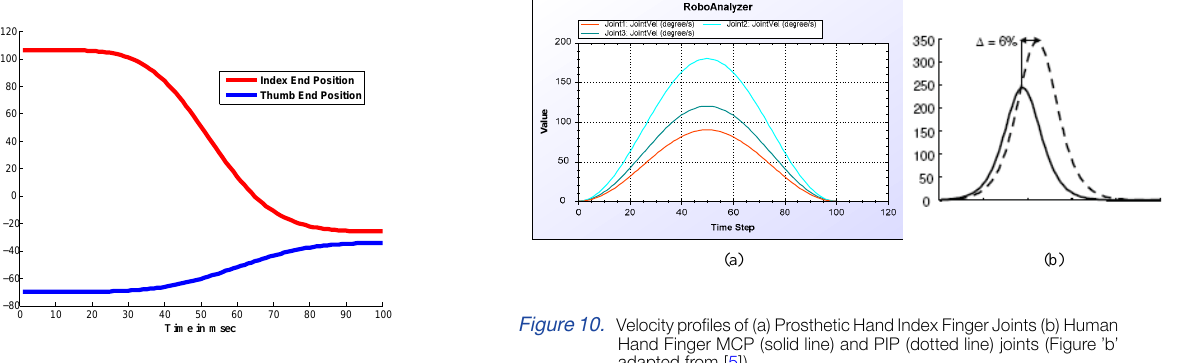
Figure 8. End Position of the Index Finger and Thumb during Pinch Grasp